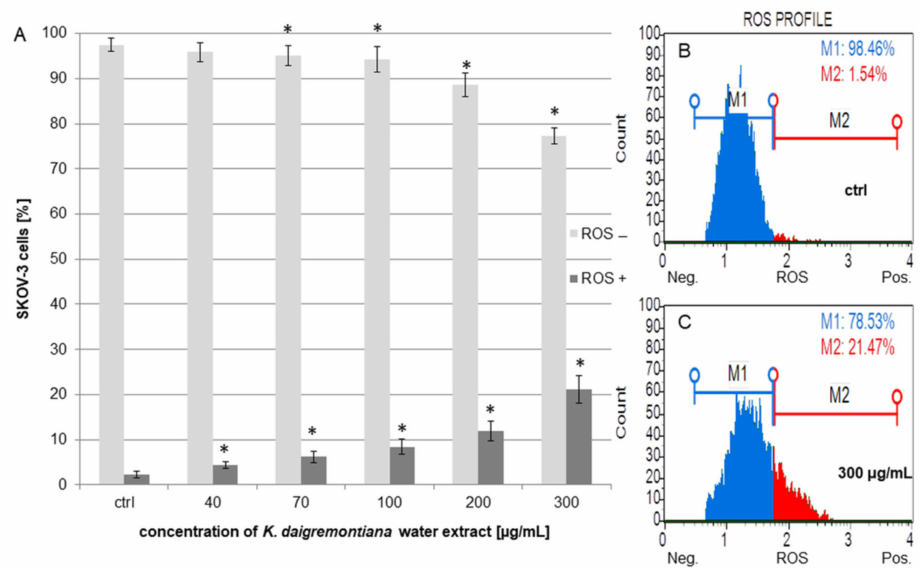
Figure 7. The oxidative stress levels in SKOV-3 cells treated with K. daigremontiana water extract for 24 h ( A ). The values represent the means ± SD of three independent experiments. Error bars indicate standard deviations. Significant differences relative to the control are marked with an asterisk “*” (the Student’s t -test, p < 0.05). The plots show the results after treating the cells with the extract concentrations of 0 µ g/mL (( B ), ctrl) and 300 µ g/mL ( C ).